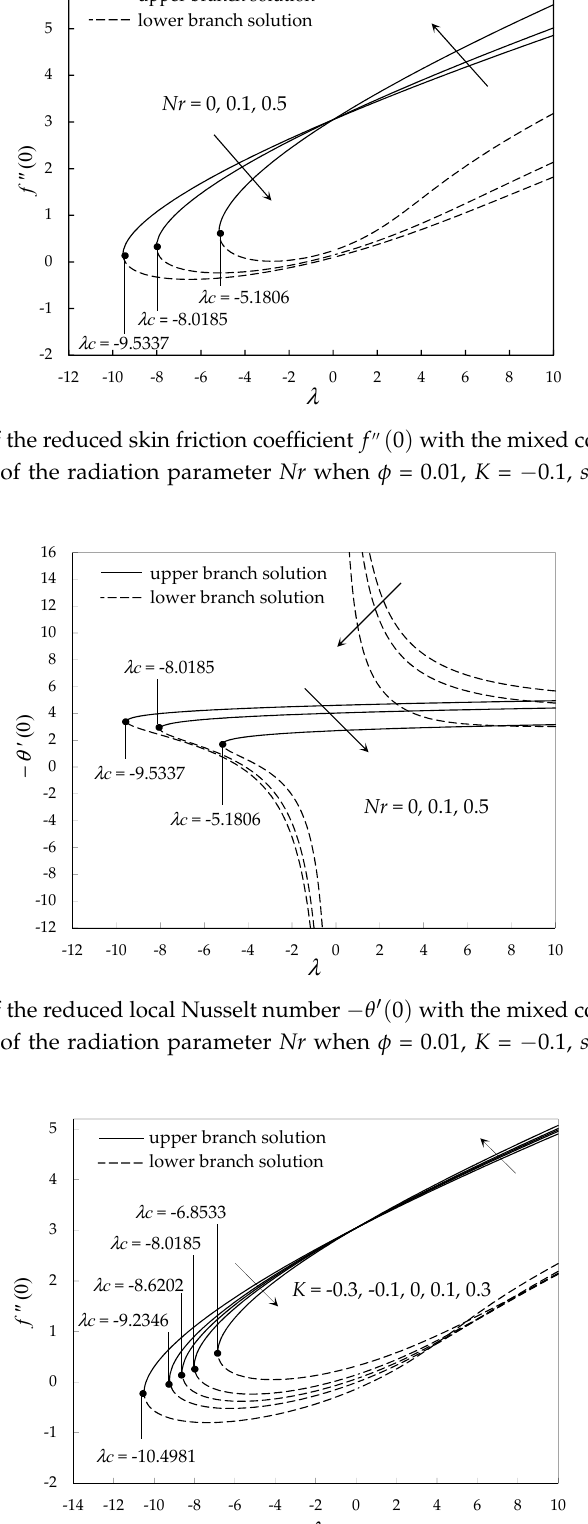
Figure 6. Variation of the reduced skin friction coefficient f (cid:48)(cid:48) ( 0 ) with the mixed convection parameter λ for various values of the heat source/sink parameter K when φ = 0.01, Nr = 0.1, s = 1 and c = − 1 for Cu-water nanofluid.